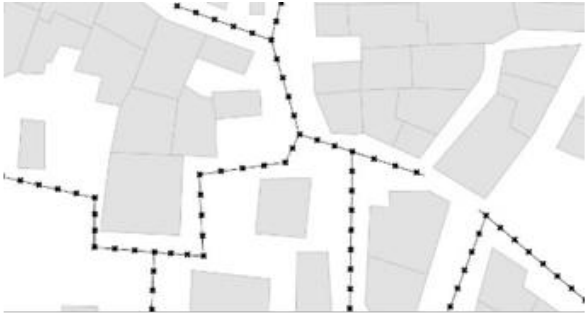
Figure 8. All potential distribution